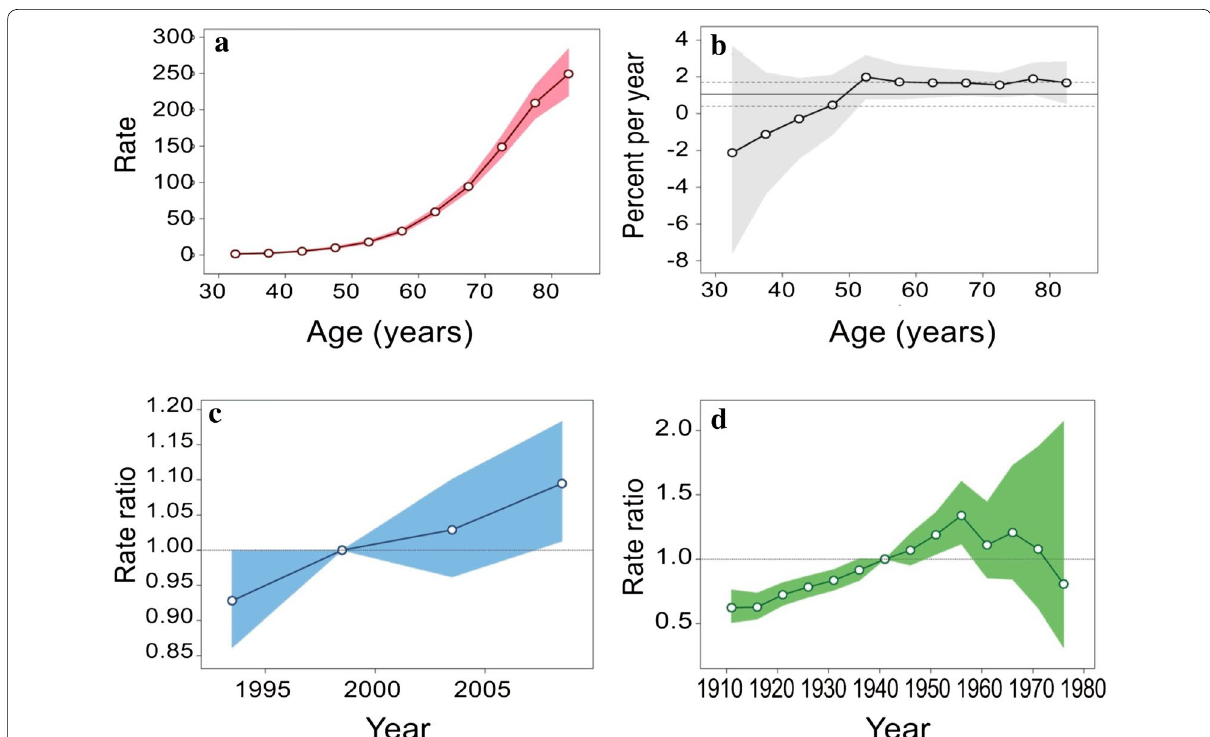
Fig. 3 Mortality of colorectal cancer in Serbia during the period 1991–2010: an age-period-cohort analysis. a Longitudinal age curves of colorectal cancer mortalities: longitudinal age curves of the mortalities (per 100,000 people) of colorectal cancer and the corresponding 95% confidence intervals (the area colored in pink ). b Local drift values for colorectal cancer mortalities: age group-specific annual percent change (%) in the mortali- ties of colorectal cancer and the corresponding 95% confidence intervals (the area colored in grey ). c Period effects on colorectal cancer mortalities: period effects obtained from age-period-cohort analyses for the mortalities of colorectal cancer and the corresponding 95% confidence intervals (the area colored in blue ). d Cohort effects on colorectal cancer mortalities: cohort effects obtained from age-period-cohort analyses for the mortali- ties of colorectal cancer and the corresponding 95% confidence intervals (the area colored in green